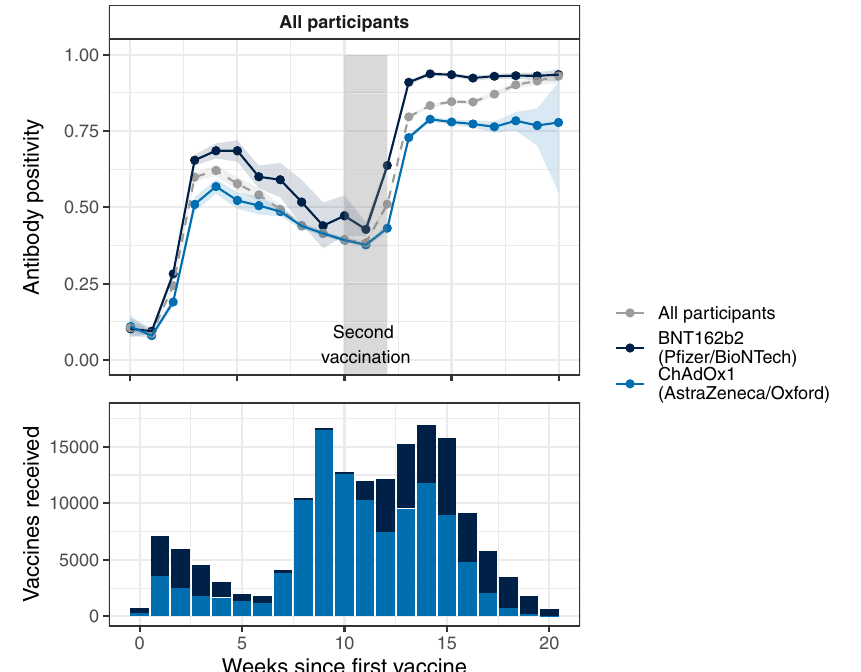
Fig. 1 Vaccine response (upper panel) and uptake (lower panel) over time. Participants are grouped by weeks since fi rst and second vaccination, and secondarily by vaccine received. The proportion of tests reported as positive (antibody positivity) within group by week is shown. Participants who had received either (i) a single dose but no second dose, or (ii) two doses of the vaccine between 10 and 12 weeks after the fi rst were included in the plot. Shaded areas on either side of the plot lines denote 95% con fi dence intervals; the grey shaded block denotes the 10 – 12 week period after fi rst vaccination. The upward trend post-second-dose observed in the all participants line is attributable to the changing proportions of ChAdOx1vs BNT162b2 vaccine after 17